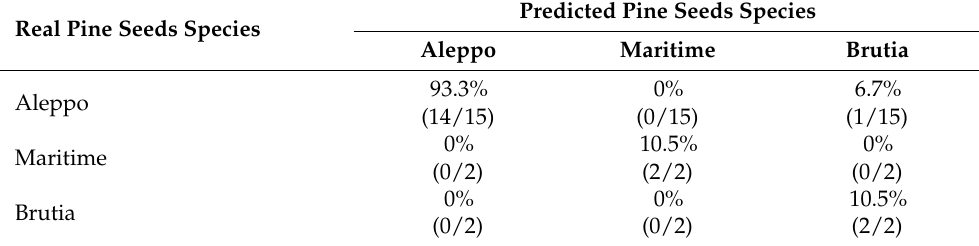
Table 4. Confusion matrix for the best PLS-DA pine seeds species discrimination model based on lipid profile chemical values autoscaled and then mean centered using 2 LV considering only the validation data. Predicted Pine Seeds Real Pine Seeds Species